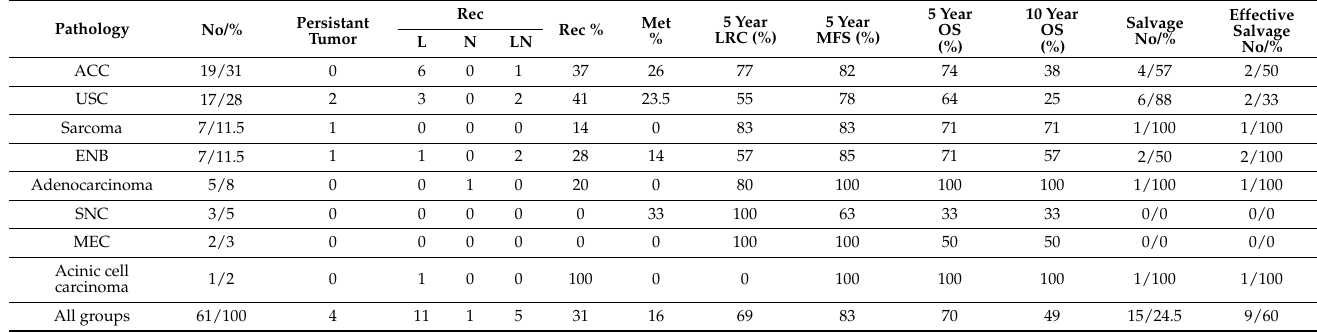
Table 2. Primary treatment results and results of salvage according to histopathological types and in all groups. Rec—recurrence, L—local, N—nodal, LN—local and nodal, ND—no data, ACC—adenoid- cystic carcinoma, USC—undifferentiated sinonasal carcinoma, ENB—olfactory neuroblastoma, MEC— mucoepidermic carcinoma, LRC—locoregional control, SNC—small cell neuroendocrine carcinoma. MFS—metastases-free survival, OS—overall